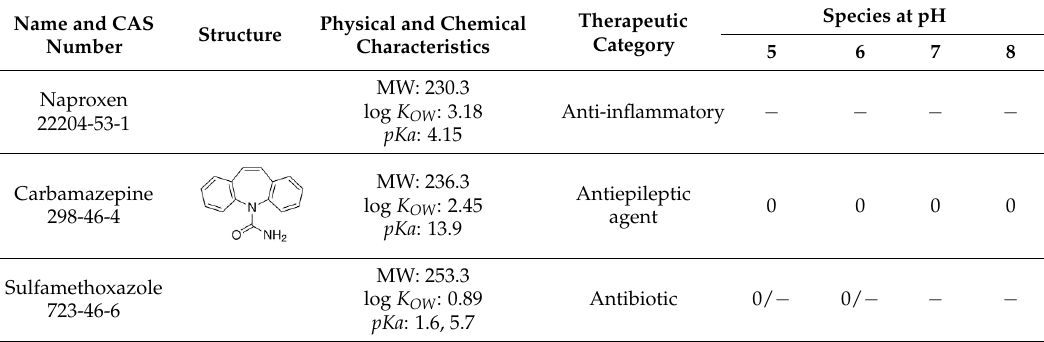
Table 1. Physicochemical properties and therapeutic category of the selected pharmaceuticals.